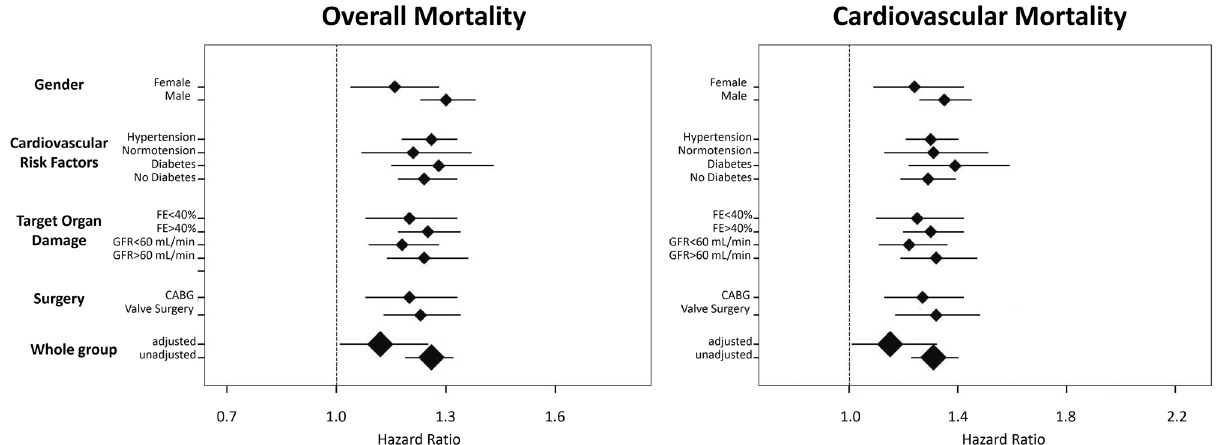
Figure 2. Hazard ratio from Cox proportional analysis describing the risk of death and cardiovascular death in the whole (unadjusted and adjusted) group of patients and in specific sub-groups for each percentage increase of red blood cell distribution width